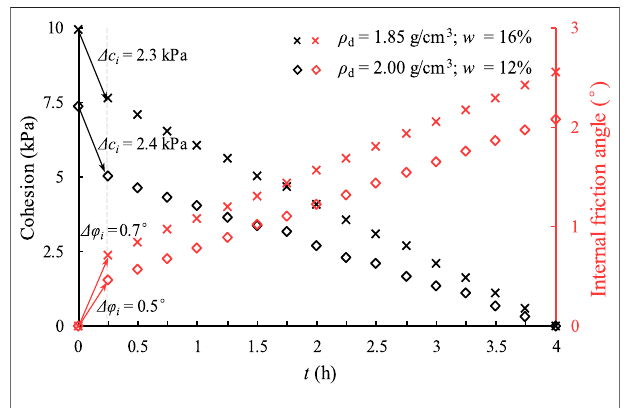
FIGURE 8 | Cohesion and Internal friction angle with thawing